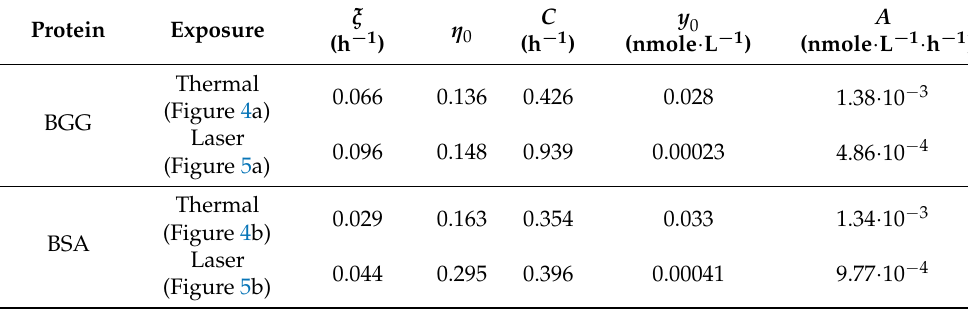
Table 2. Parameters of the model function (30).